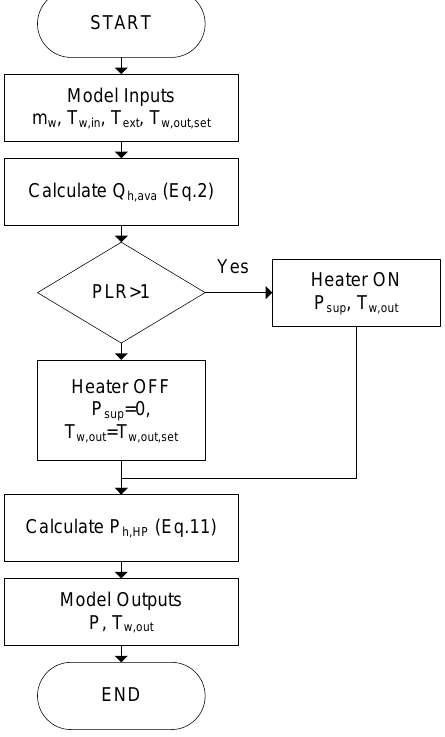
Figure 2. Heat pump model flowchart.